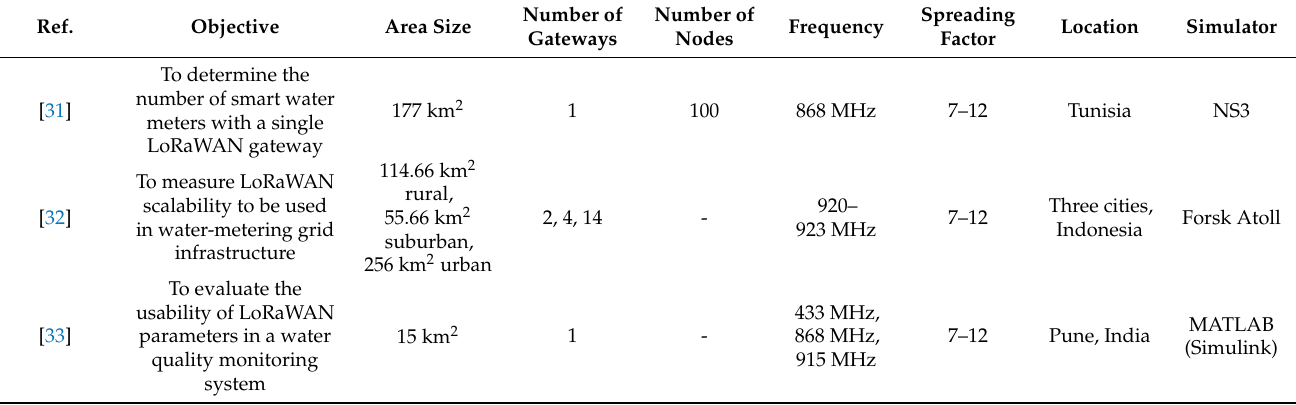
Table 1. A comparison of LoRaWAN-based simulated applications for water management systems.